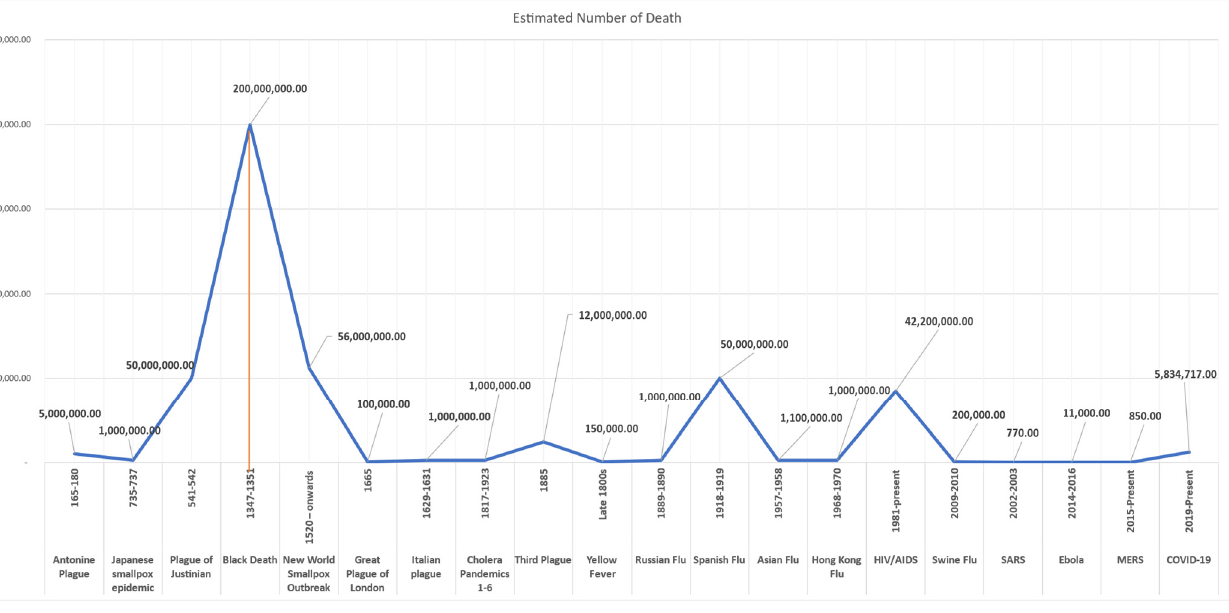
Figure 2. The Occurrence of Pandemics in the World Time Horizon; Source: [23–25].